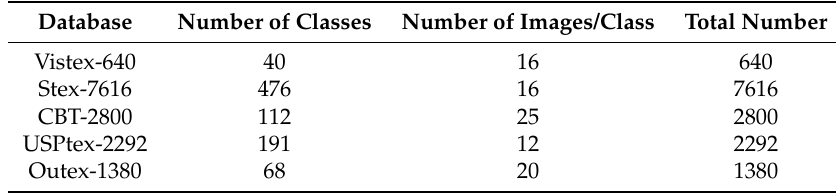
Table 1. Summary of texture databases used in the experimental